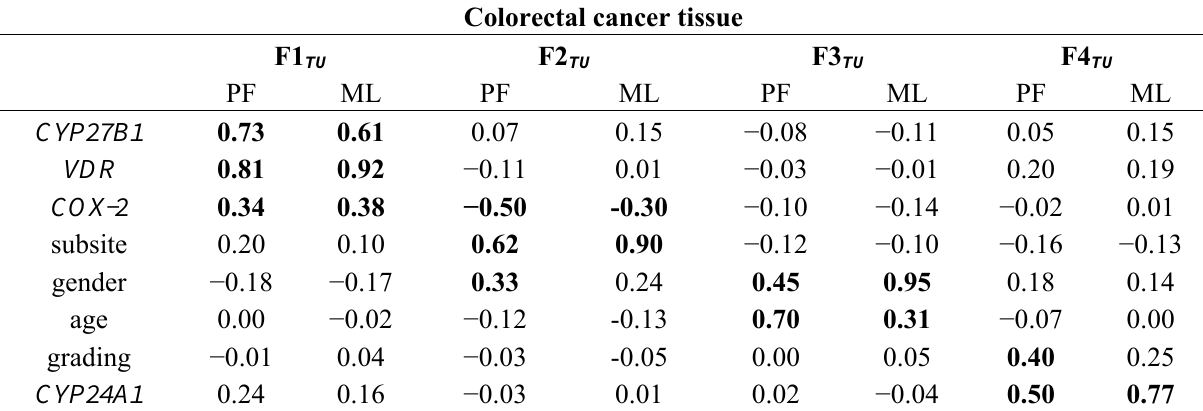
Table 1. Results from exploratory factor analysis of eight mutually correlated variables with respect to colorectal cancer and adjacent mucosal tissue. Loadings on Factors (F) (=relation between independent factors and measured variables) were calculated by Principal Factor Method (PF) and Maximum Likelihood Method (ML). Salient loadings ( i.e. , “significant” associations with a factor) are shown in